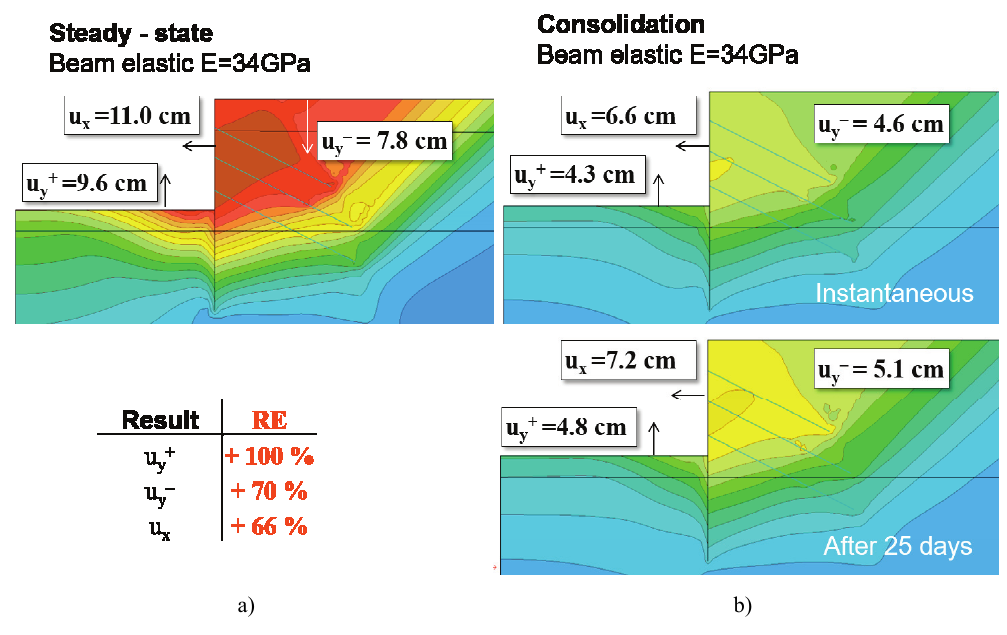
Fig. 18. Comparison of maximal displacements derived from: